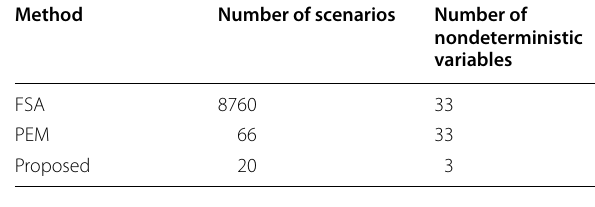
Table 8 Number of scenarios and nondeterministic variables Method